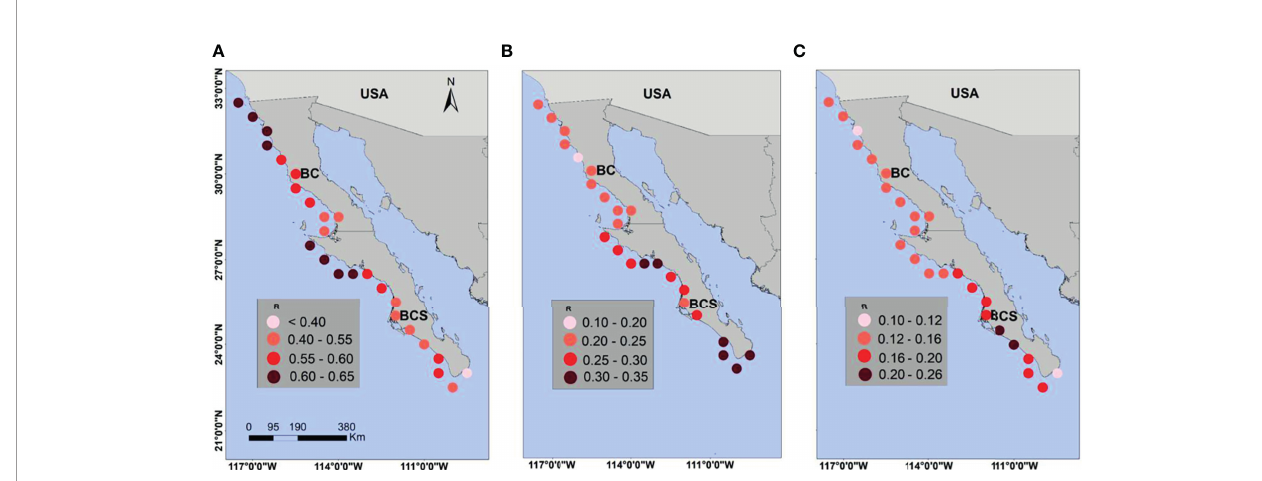
FIGURE 5 | Correlation coef fi cients, R, for wave power and (A) ONI, (B) PDO, (C) AMO climate indices. Points indicate 95% con fi dence level.